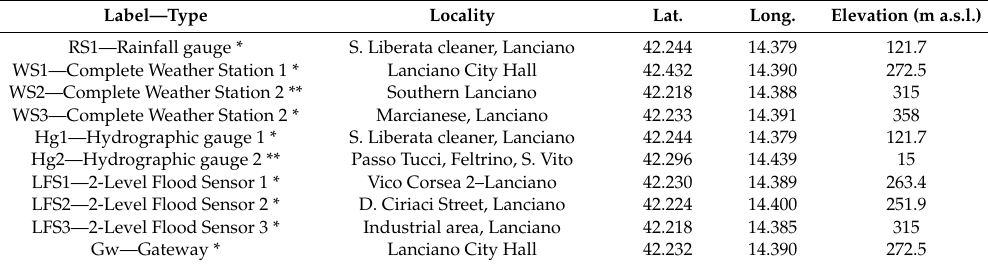
Table 7. Gauges composing the urban EWS (location in Figure 17). * Sensors of the Municipality of Lanciano; ** Sensors of the Functional Center and Hydrographic O ffi ce of the Abruzzo